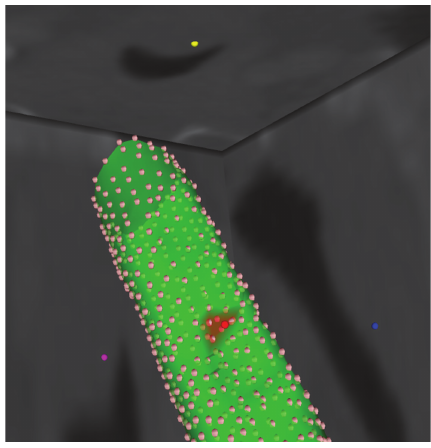
Figure 6: Visualisation of the interaction point (red) and its projections (yellow, pink and blue) onto the slices as well as the CT texture data on the slices representing the current interaction point position.